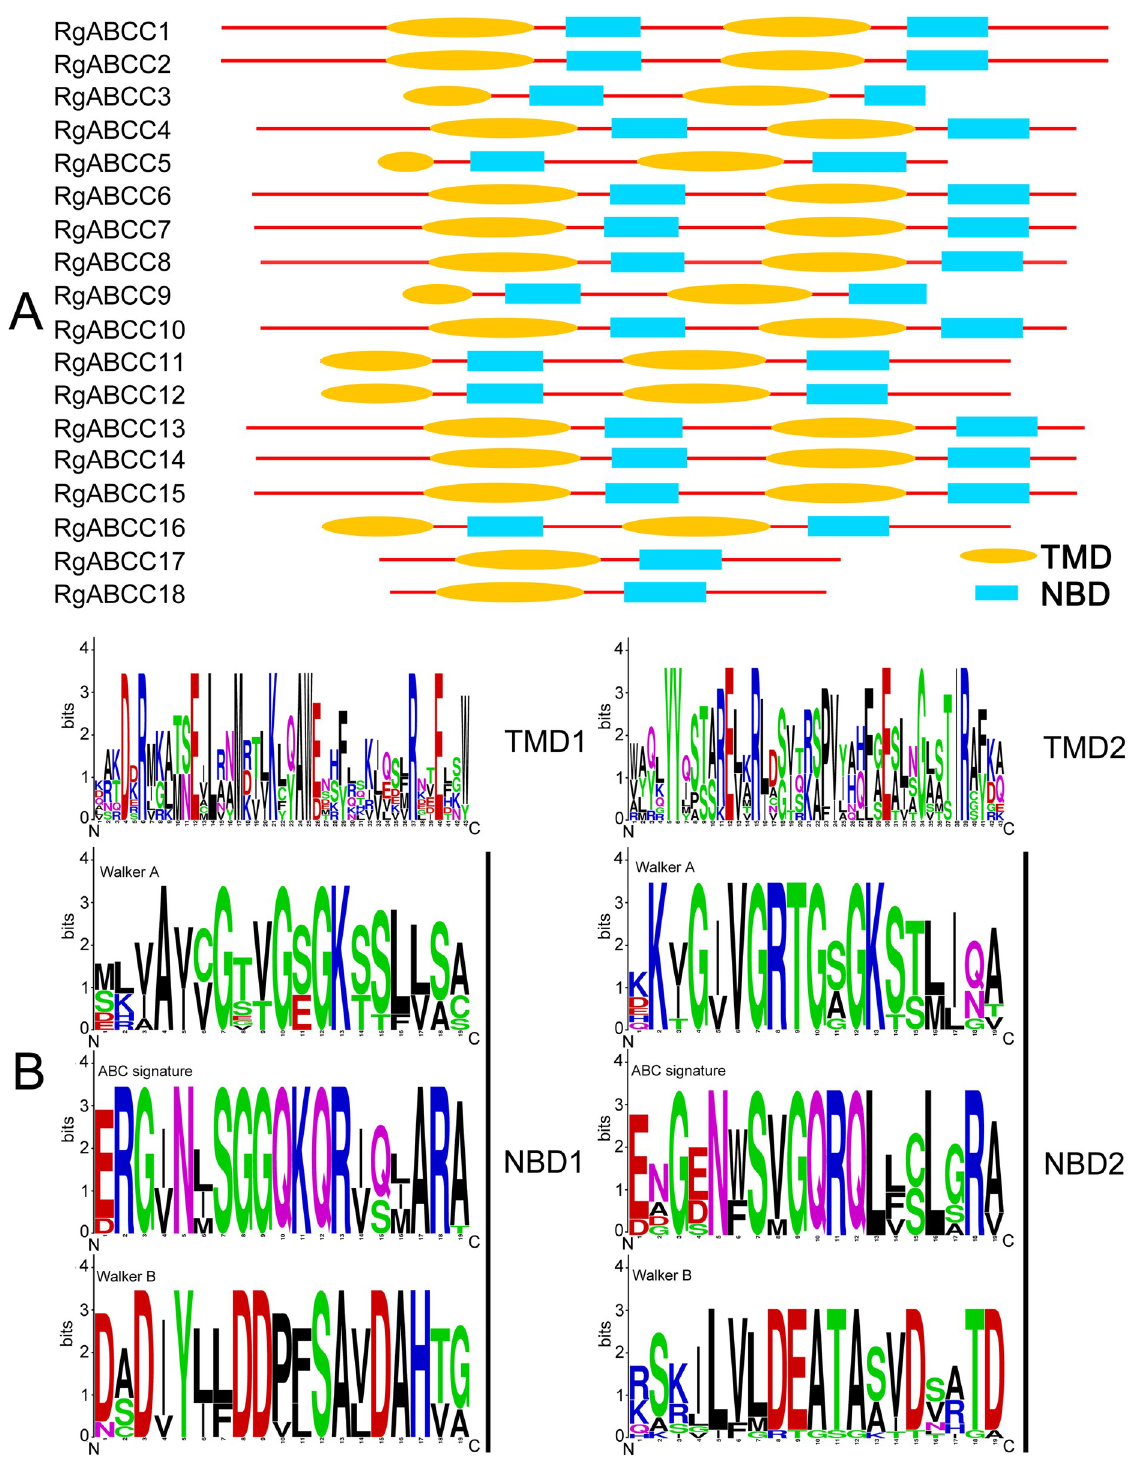
Fig 2. Conserved domain analysis of the RgABCCs. (A) Schematic diagram of the domain arrangement in different RgABCCs; (B) sequence logo of amino acids conserved in different domains (Note: The Y-bits represent conservation of amino acids at that position